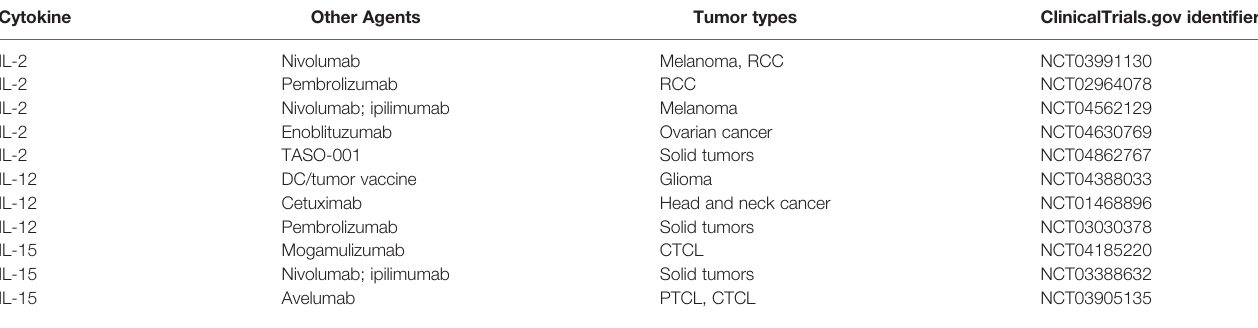
TABLE 3 | Cytokine-based Immunotherapy for Cancer: Clinical